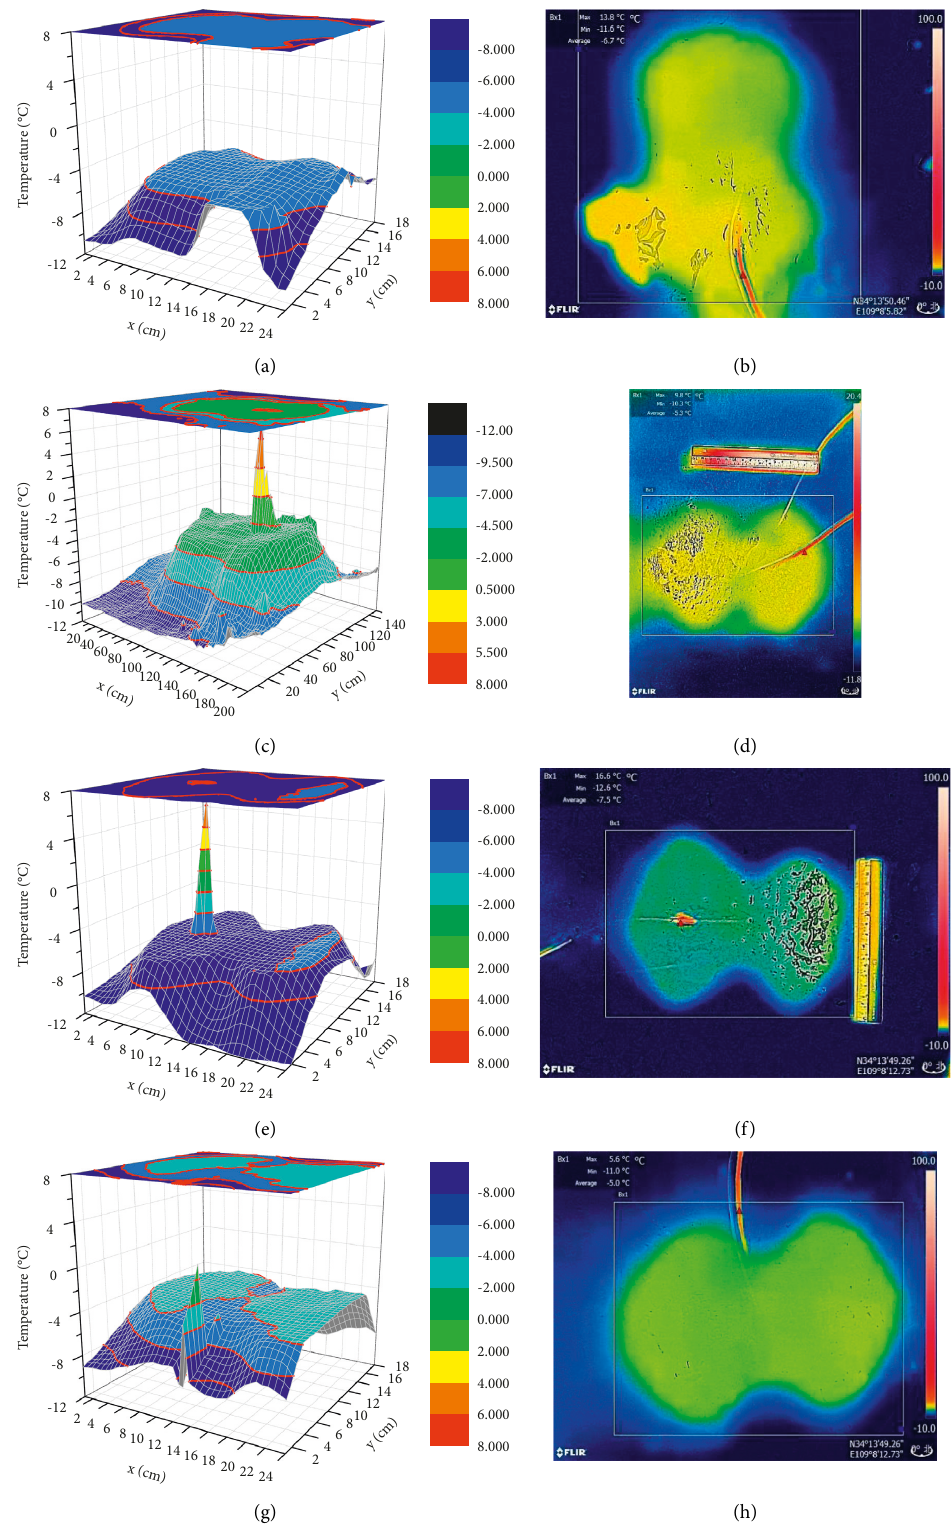
Figure 17: 3D stereogram and IR thermogram of surface temperature at different doping levels. (a) PC-1. (b) PC-2. (c) 0.6CFC1-1. (d) 0.6CFC1-2. (e) 0.6CFC2-1. (f) 0.6CFC2-2. (g) 0.6CFC3-1. (h)